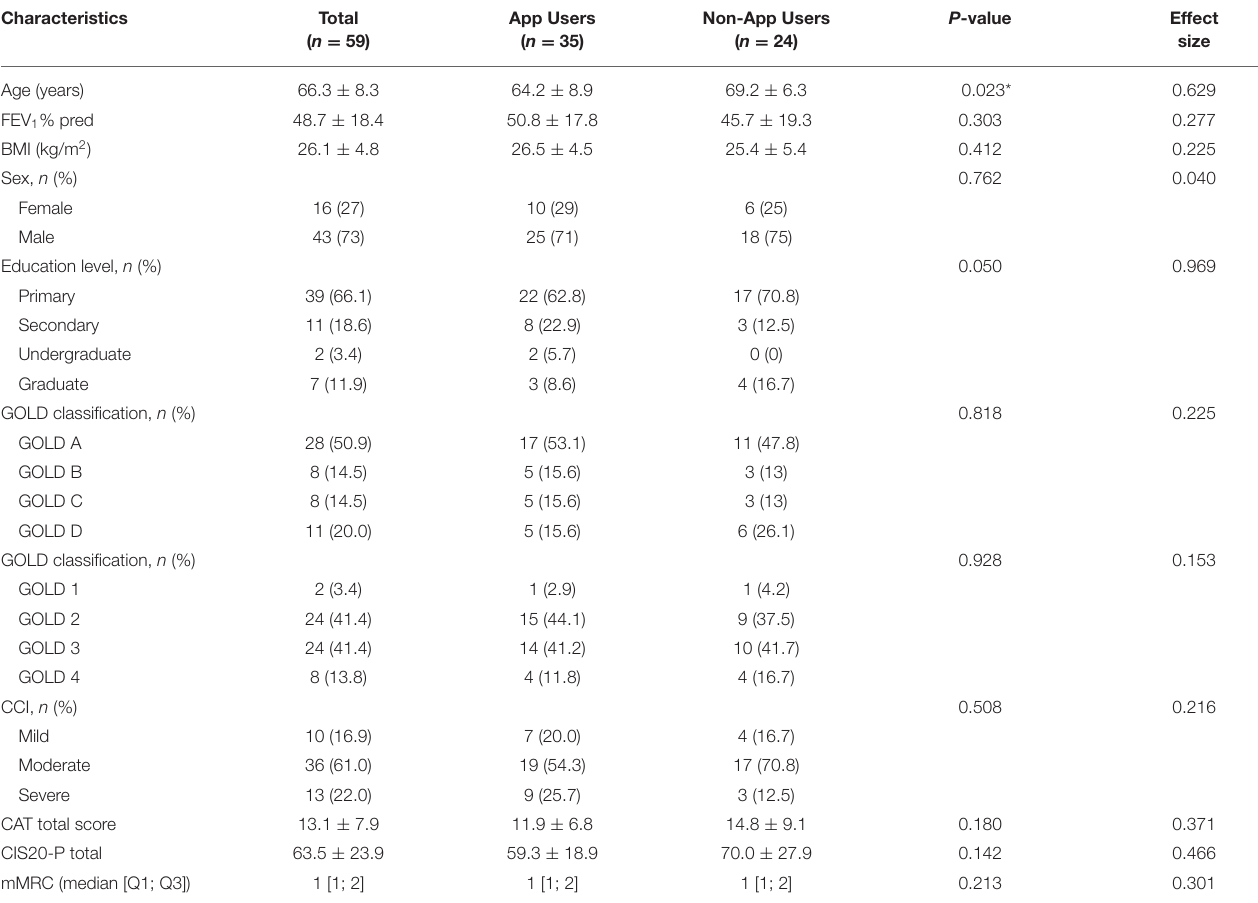
TABLE 1 | Participants’ sociodemographic and clinical characteristics.